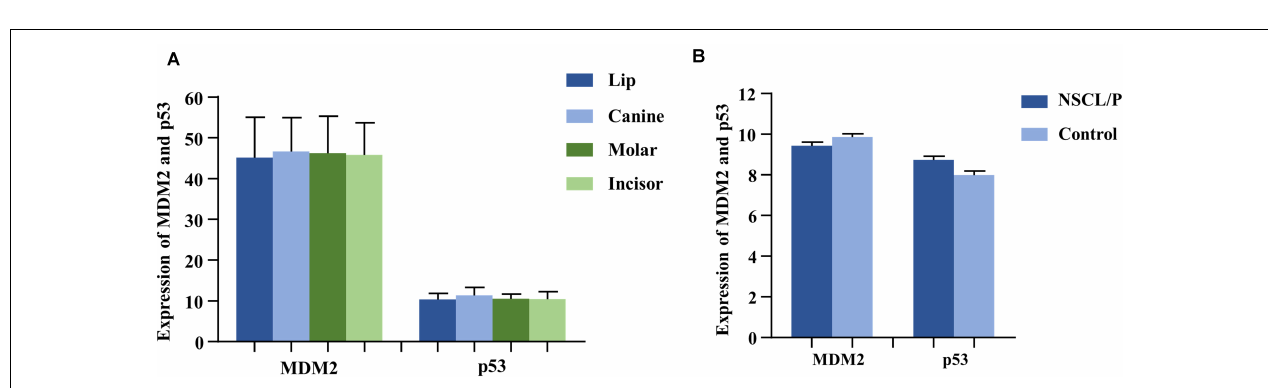
FIGURE 1 | Expression of miR-605-3p (A) and miR-605-5p (B) in human cell lines. COS-7 and HEK-293 cells were transfected to express either the miR-605-3p A/G allele. The miR-605-3p expression levels were estimated by qRT-PCR; n = 3 (colonies) for each group and results are shown as mean values with the SD normalized to U6. (C) Dual luciferase reporter assays in COS-7 cells and HEK-293 cells demonstrated that MDM2 was direct target of miR-605-5p . MDM2 mRNA (D) and protein (E) expression in COS-7 and HEK-293 cells after transfection with miR-605-5p mimics. Transcript levels were analyzed by qPCR and normalized to GAPDH levels (** P < 0.01; *** P < 0.001).